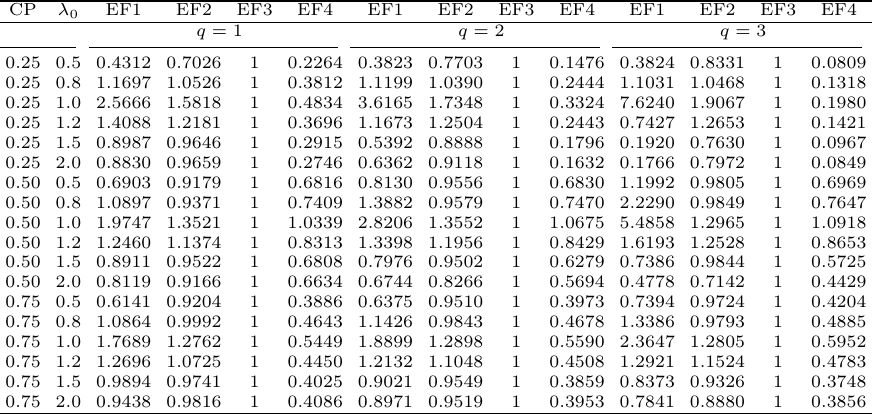
Relative efficiencies of the estimators of (cid:21) q (when (cid:21) = 1 ) under Type II censoring